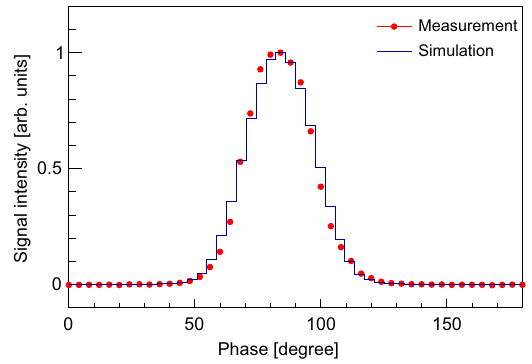
FIG. 15. Longitudinal phase distributions measuredusingHOPG- BSM in MEBT1. The voltage of the buncher1 was 0.21 MV.